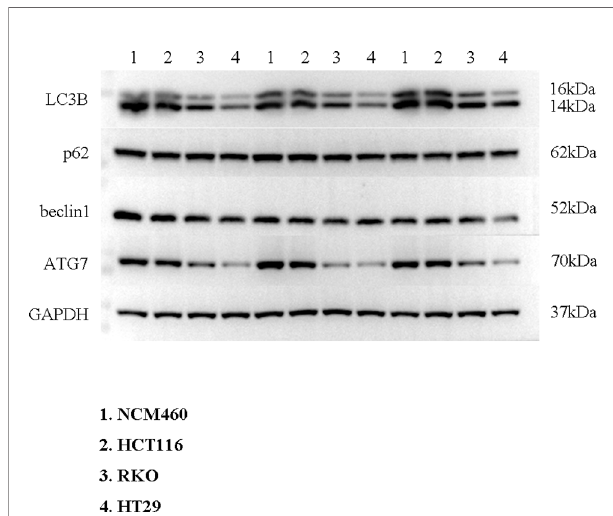
FIGURE 10 | The protein expression of autophagy-related genes was detected by Western blot.